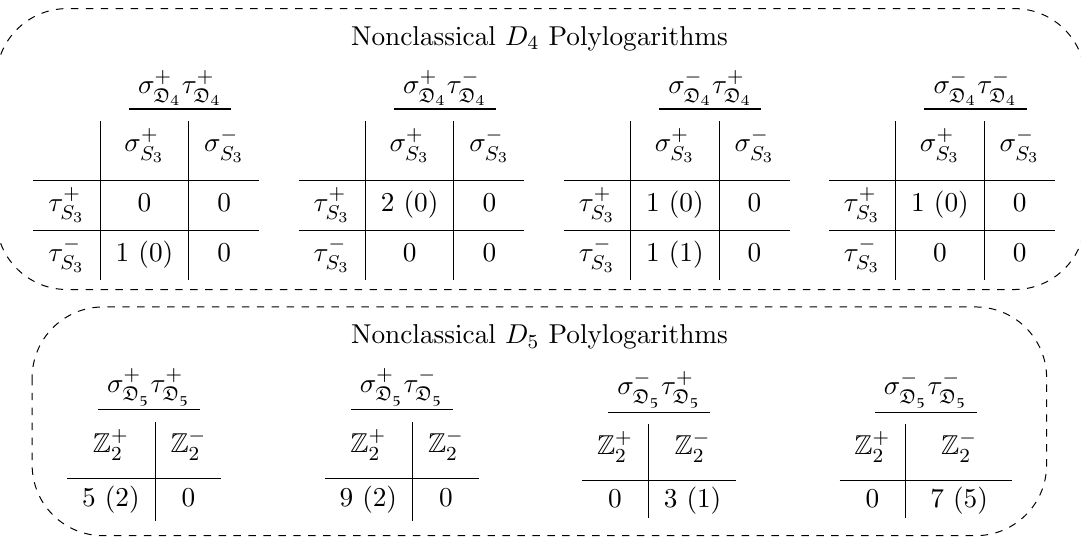
and D cluster 4 5